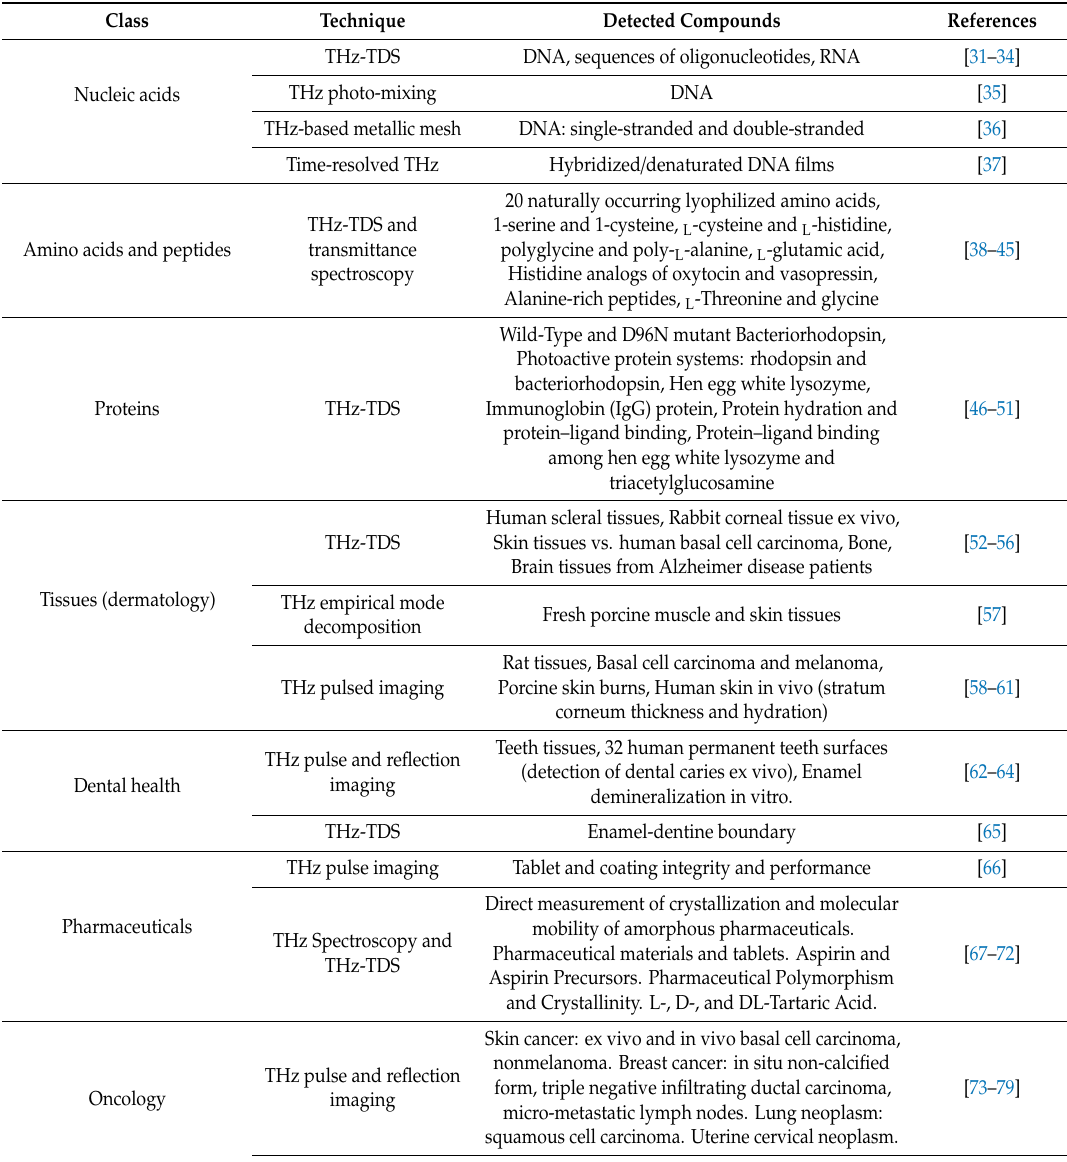
Table 1. Overview of the biomedical applications of THz